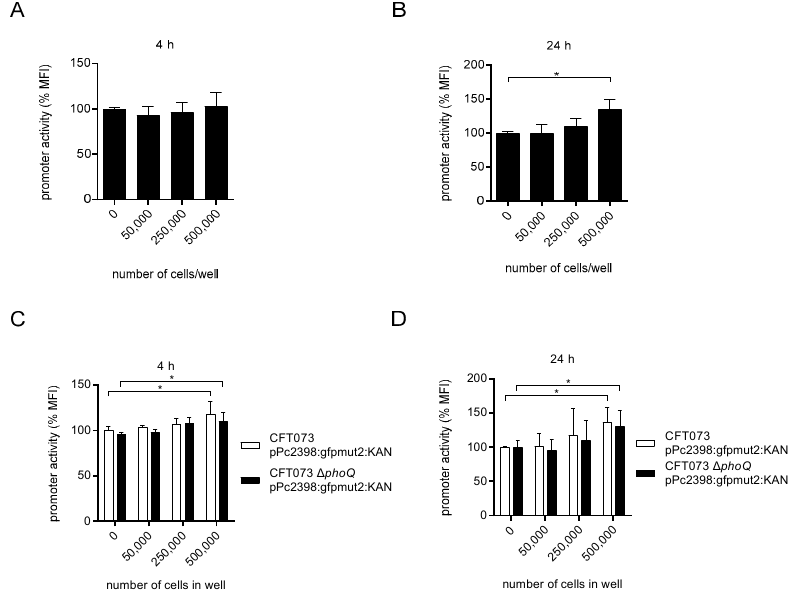
Figure 3. The PhoQ/P two-component system does not influence P2 induction by THP-1 cells. We co-cultured CFT073 ∆ phoQ pPc2398:gfpmut:KAN (1.6 × 10 7 bacteria/well) in RPMI-1640 medium in the absence or presence of titrated amounts of monocytic THP-1 cells as indicated ( A , B ). We deter- mined the P2 promoter activity after a culture period of 4 ( A ) or 24 h ( B ) by flow cytometry. In ( C , D )